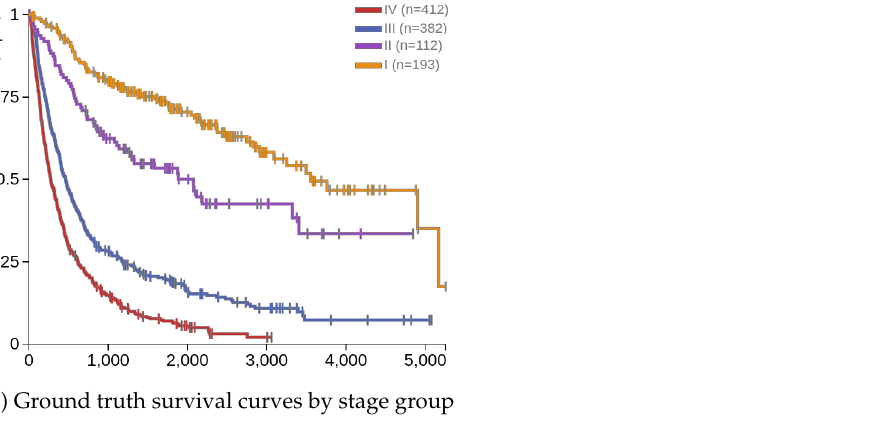
Figure 2. Survival curves for four patients in the validation set with patient IDs of 37, 29, 0, and 9. ( a , b ) Individual survival curves from estimator; ( c ) Survival curves according to the overall stages in validation set (with a time unit of